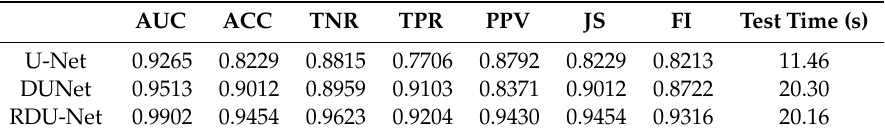
Figure 10. Comparison of segmentation results of U-Net, DUNet and RDUN-net. Red box: under segmentation; Orange Box: over segmentation; Blue box: wrong identification of conveyor belt; Green box: good segmentation. Table 3. Performance of the three models